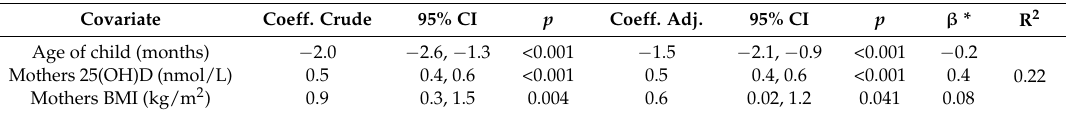
Table 4. Predictors for plasma 25(OH)D (nmol/L) concentrations in a random sample of Nepalese infants. Covariate Coeff. Crude 95% CI p Coeff. Adj.